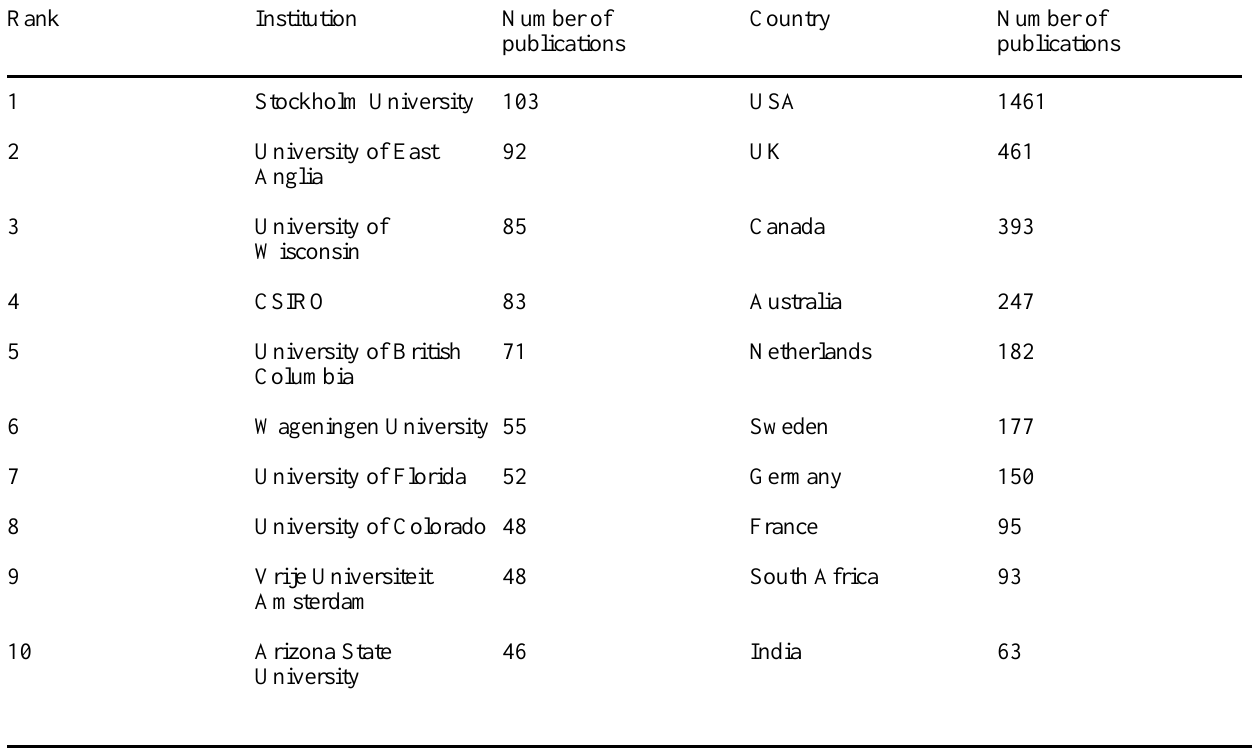
Table 6. The top ten most productive institutions (left) and countries (right). The publications are distributed according to the institutions and countries of the lead author. For 121 publications, this information was not